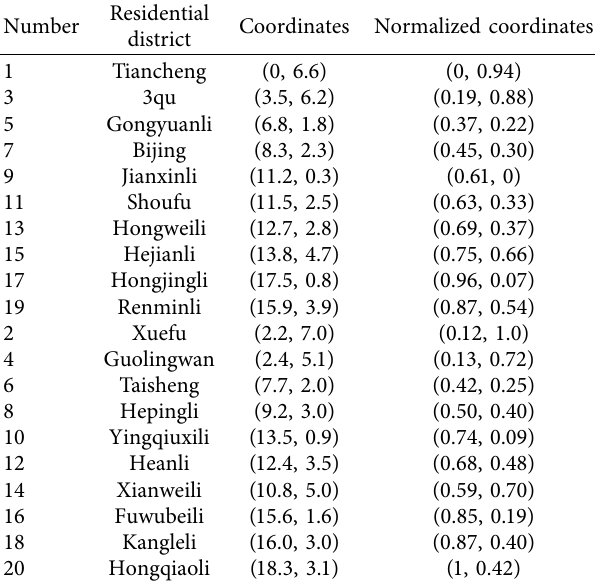
Table 4: Coordinates of the 20 selected residential